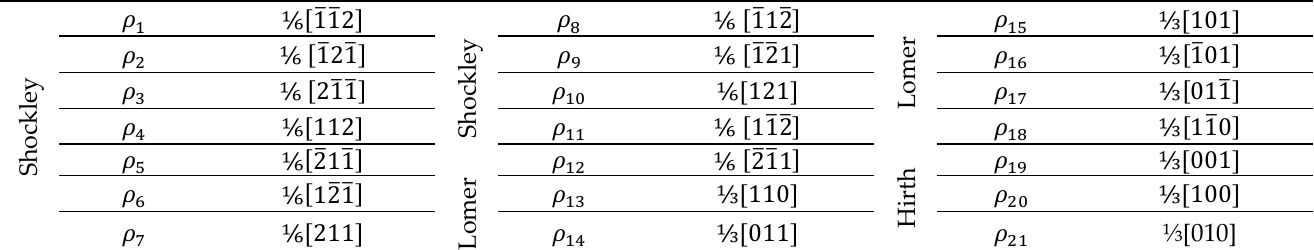
Table 3. Partial dislocation densities ρ p .